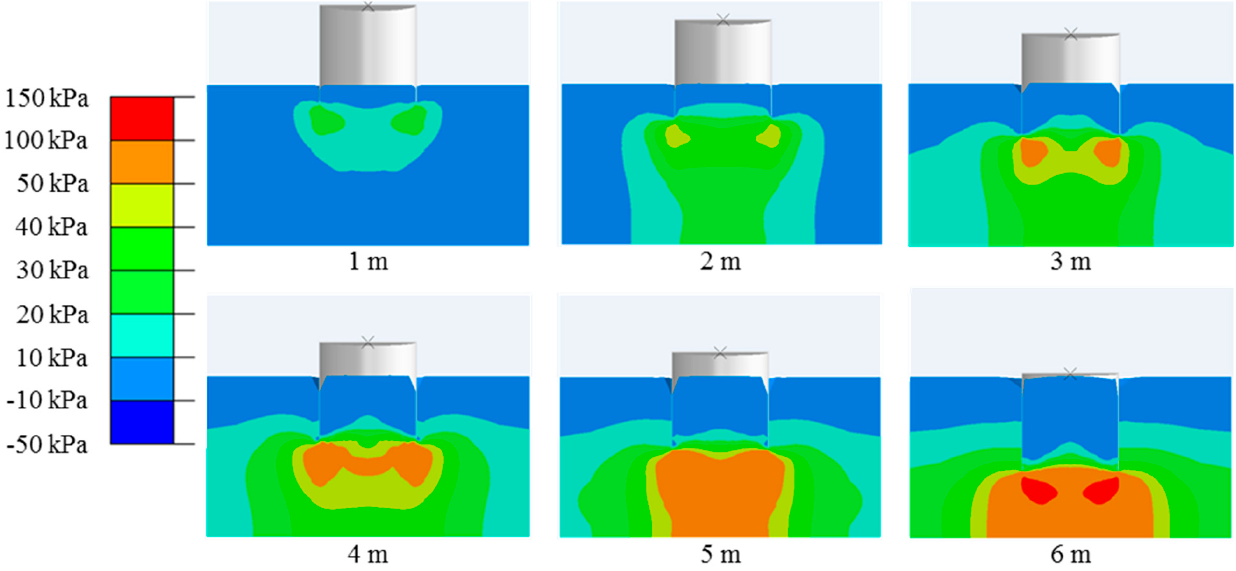
Figure 5. Excess pore pressure distribution during jacked penetration.